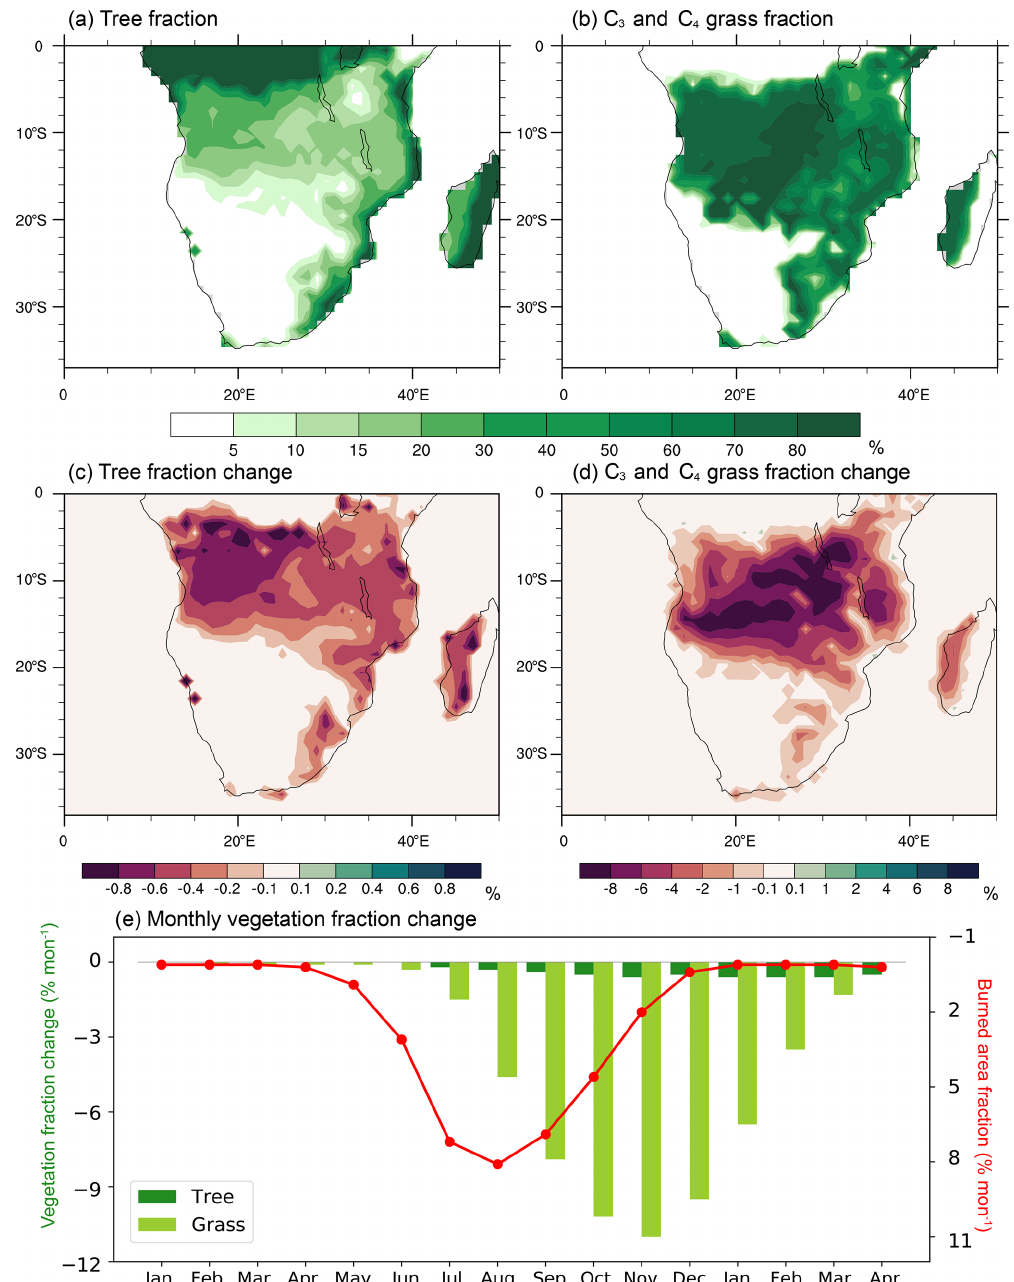
Figure 7. 2000–2013 annual (a) tree fraction (%) and (b) C 4 and C 3 grass fraction (%) in FIREOFF; 2000–2013 annual fire effects on (c) tree fraction and (d) grass fraction, and (e) monthly fire effects on the fractional coverage of trees and C 4 and C 3 grasses (%month − 1 ) with burned area fraction (%month − 1 , red curve) overlaid (the areal-average fire effect is calculated using grids with an annual burned area fraction > 10%). The y axis of burned area fraction in panel (e) is